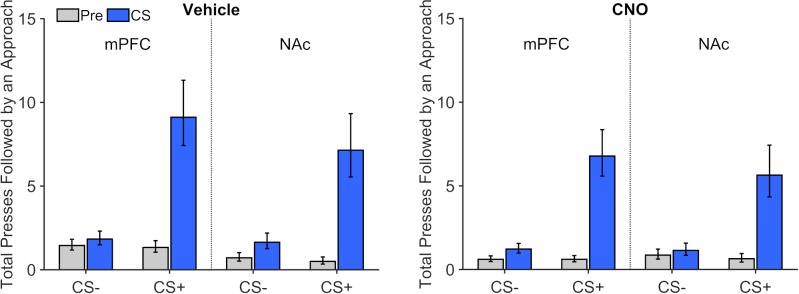
Frequency of presses that were followed by a food-cup approach during PIT testing by rats expressing the inhibitory DREADD hM4Di following microinjection of CNO or vehicle into the mPFC or NAc in Experiment 3A.Data from pre-CS (gray) and CS (blue) periods are plotted separately. Error bars represent ±1 standard error of the estimated marginal means from the corresponding fitted generalized linear mixed-effects model. The cue-induced increase in the frequency of these press-approach sequences was specific to the CS+ (CS Type * CS Period interaction, t(240) = 7.34, p<0.001), which did not vary as a function of drug and/or injection site (ps >0.689), nor were there any main effects of these treatment variables (Drug effect, t(240) = 1.05, p=0.294; Site effect, t(240) = −0.26, p=0.798; Drug * Site interaction, t(240) = 1.28, p=0.203).